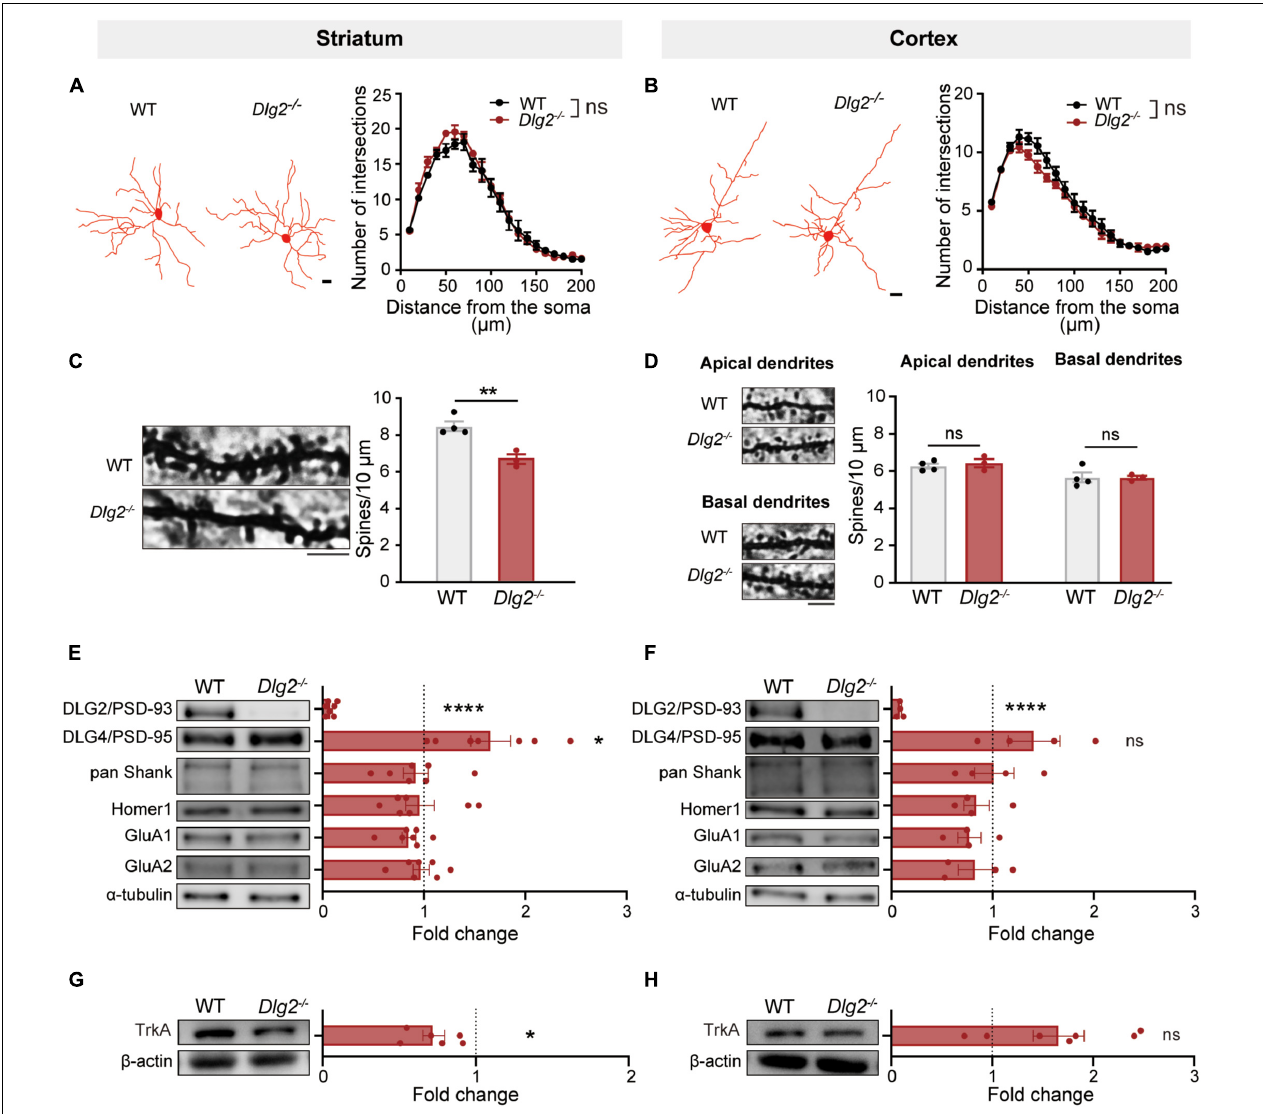
FIGURE 3 | The consequence of a DLG2/PSD-93 deficiency on excitatory synapses is prominent in the striatum compared to that in the motor cortex. (A,B) Golgi-Cox staining revealed no changes in dendritic arborization of SPNs in the dorsolateral striatum (A) or pyramidal cells in the cortex (B) of Dlg2 -/- mice. Left, representative traces. Scale bars, 15 µ m; right, quantification by the Sholl analysis. A total of 8–12 SPNs and 13–15 pyramidal neurons per animal were analyzed (WT, n = 4 mice; Dlg2 -/- , n = 3 mice). (C,D) The number of dendritic spines was significantly reduced in striatal Dlg2 -/- SPNs (C) , but not in cortical pyramidal neurons (D) . Left, representative images of dendrites. Scale bar, 5 µ m. A total of 12–15 neurons per animal were analyzed for spine quantification (WT, n = 4 mice; Dlg2 -/- , n = 3 mice; ** p < 0.01, Student’s t -test). Representative blot images of postsynaptic density-related molecule in the synapse-enriched fraction of the striatum (E) and the cortex (F) . Immunoblot analysis confirmed the absence of DLG2/PSD-93 at striatal and cortical synapses in Dlg2 -/- mice. Note that DLG4/PSD-95 protein levels were significantly increased in the striatal, but not the cortical, synaptic fraction of Dlg2 -/- mice. No other changes in synaptic composition were found. (G,H) TrkA was significantly decreased in the striatum of Dlg2 -/- mice, but not in the cortex. * p < 0.05; **** p < 0.0001; ns, not significant. Student’s t